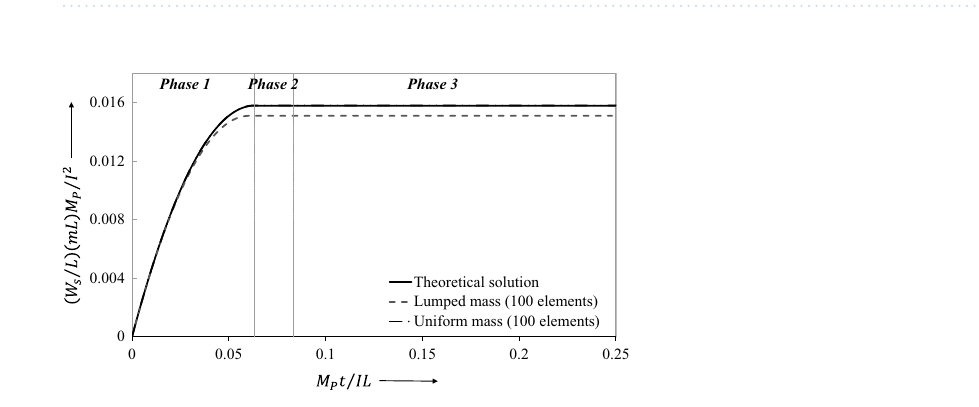
Table 3. Theoretical and LCP results of impulsively loaded beam with bending shear interaction.